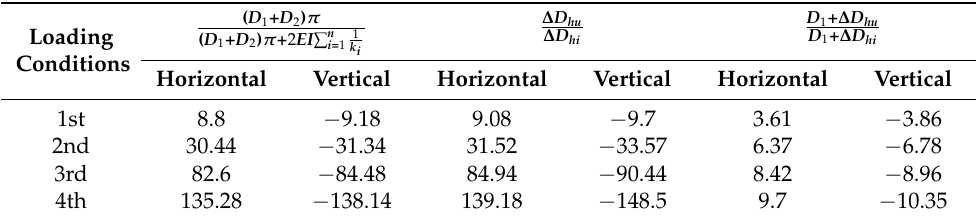
Table 6. Convergence deformations for the modified uniform rigidity rings with effective ratios of the transverse bending rigidity calculated using different methods (unit: mm).